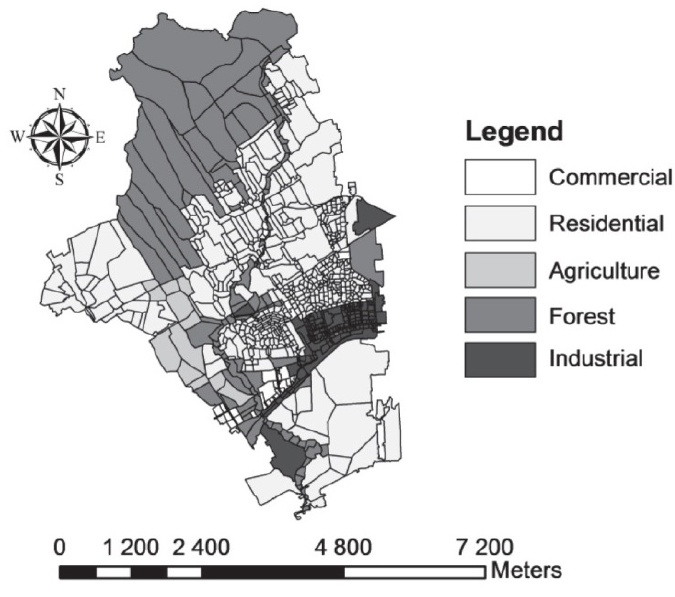
Figure 2. Data concerning flow rates were available in the form of daily averages. The daily average flow rate from 2006 to 2011 was 0.74 m 3 /s and the minimum recorded for those years was 0.18 m 3 /s. Two types of drainage networks exist in the watershed. First, from the upstream to the center of the watershed, runoff is drained trough ditches and stormwater pipes that conduct flow to various watercourses, among which the Beauport River is the principal. Fifteen retention basins are located in this area of the watershed. Second, in the downstream part of the watershed ( i.e ., in the subwatersheds illustrated in blue and green in Figure 2), runoff is drained through combined sewer pipes. Combined sewer overflows (CSOs) can occur in this area during rainfall, as detailed in Section 2.2.2.